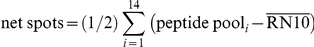
Background and net ELISpot results normalized to per million
PBMCs.The net spots were calculated according to the following
formula:where
RN10 is the average of the spots from the two negative control
wells. The summation is over all 14 wells in the plate layout which
contained overlapping pooled HBsAg peptides for each volunteer, and
the factor of 1/2 normalizes for each peptide appearing twice in the
matrix layout. Because of the 14 summations the effect of a slightly
low or slightly high background (measured over only 2 wells) gets
amplified in the final net spots count. The immune response would be
expected to be strongest in the post-treatment time interval and to
wane in the follow-up period, but in fact variability was often high
in the follow-up period. This may reflect non-specific immune
activation due to other maladies such as malaria or to the natural
course of engaging a chronic HBV infection.